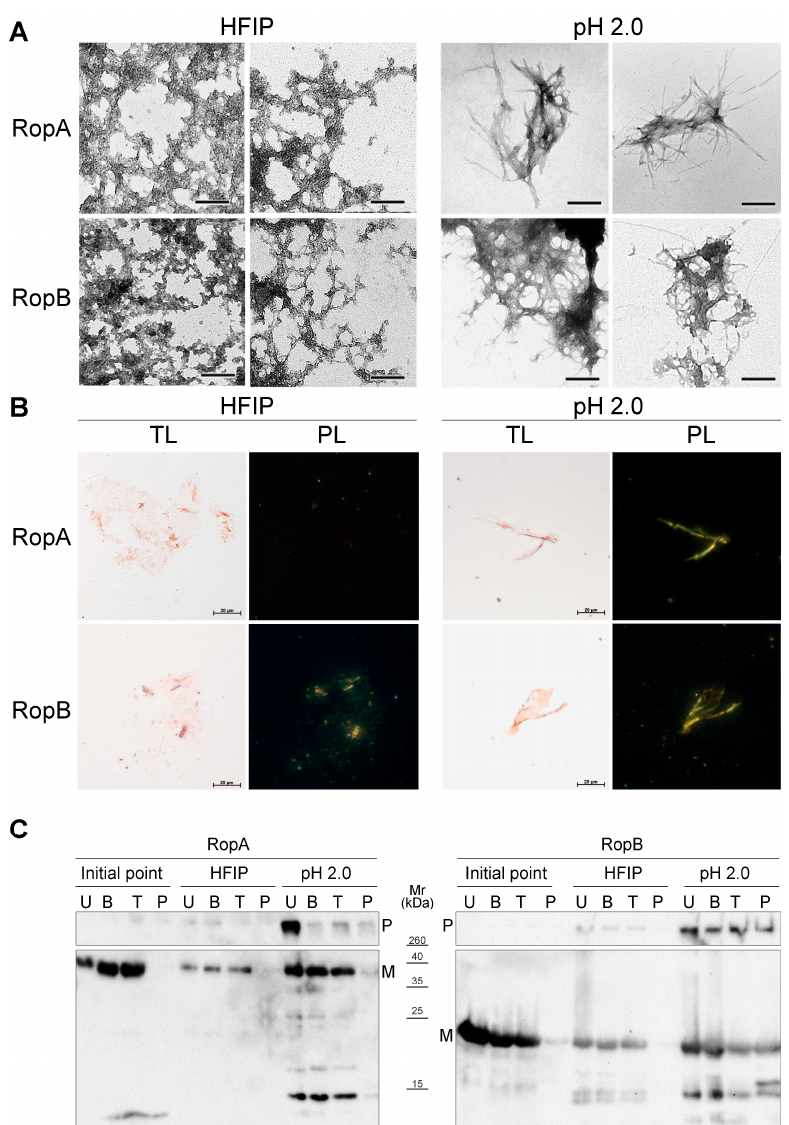
Figure 4. Amyloid properties of RopA and RopB fibrils formed in vitro. ( A ) TEM images of the in vitro obtained RopA and RopB aggregates and fibrils prepared either in HFIP or acidic conditions (pH 2.0). Scale bar is equal to 200 nm. ( B ) Polarized light microscopy of the Congo Red (CR)-stained RopA and RopB samples prepared either in HFIP or acidic conditions (pH 2.0). TL—transmitted light, PL—polarized light. Scale bar is equal to 20 µ m. ( C ) Detergent and protease resistance of the RopA and RopB aggregates and fibrils detected by Western blot. Initial point—proteins solubilized in phosphate-bu ff ered saline (PBS); HFIP and pH 2.0—protein aggregates were obtained in the corresponding bu ff ers. U—unboiled samples treated with 2% cold SDS; B—boiled with 2% SDS; T—treated with trypsin; P—treated with pepsin; P—polymers; M—monomers. Corresponding molecular weights (kDA) are